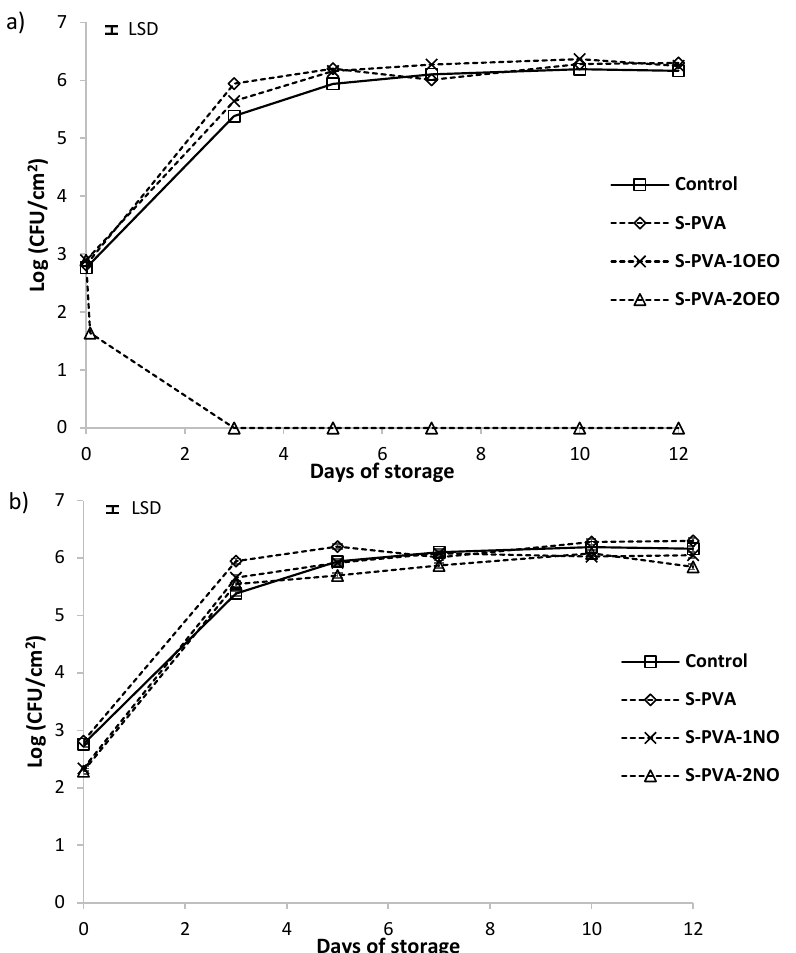
Figure 6. Population viability of Aspergillus Niger on PDA medium incubated at 25 °C. ( a ) Films with and without oregano essential oil (OEO) and ( b ) films with and without neem oil (NO). Mean values for each incubation period and 95% LSD interval are included in the plot. (LSD = ±0.05).